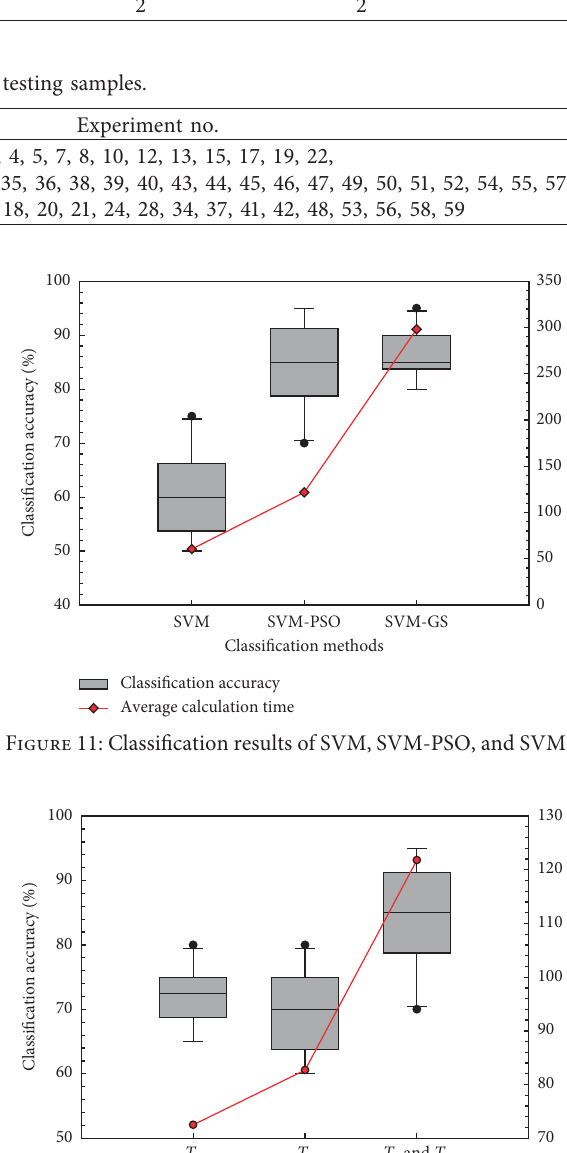
1 , T 2 , and both T 1 and T 2